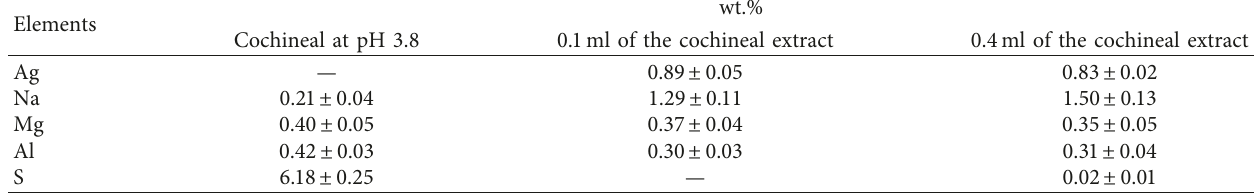
Table 2: Major elemental composition (weight percent) of cochineal pigment and AgNPs synthesized from 0.1 and 0.4ml of the cochineal extract. Elements